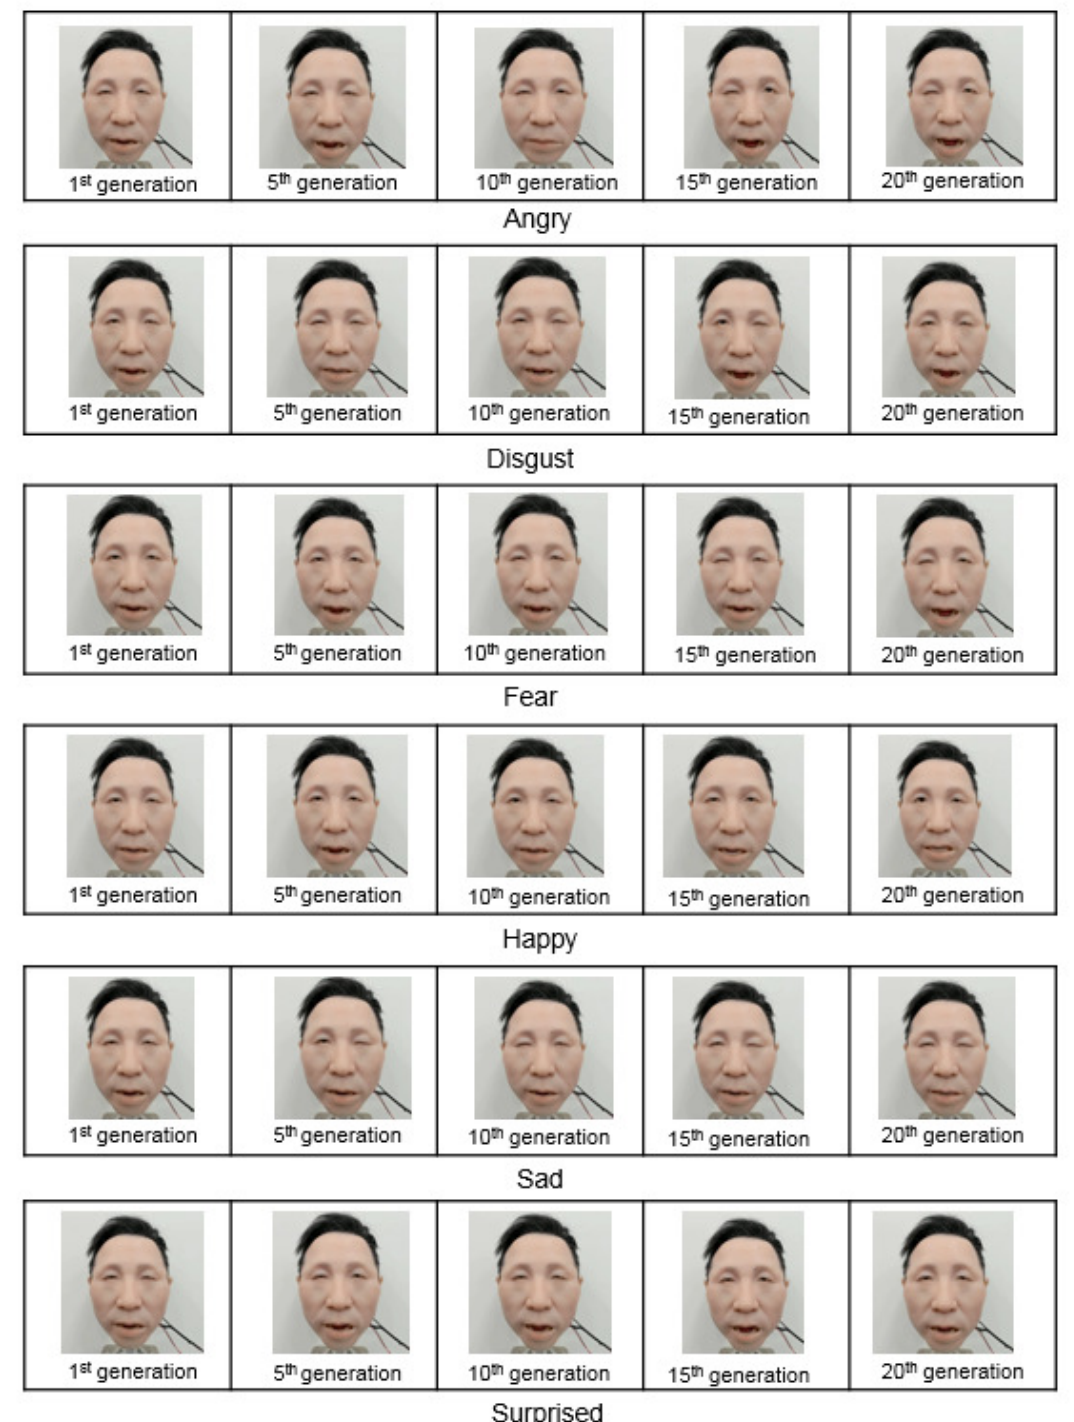
Figure 11. Evolution of different facial expressions in older male